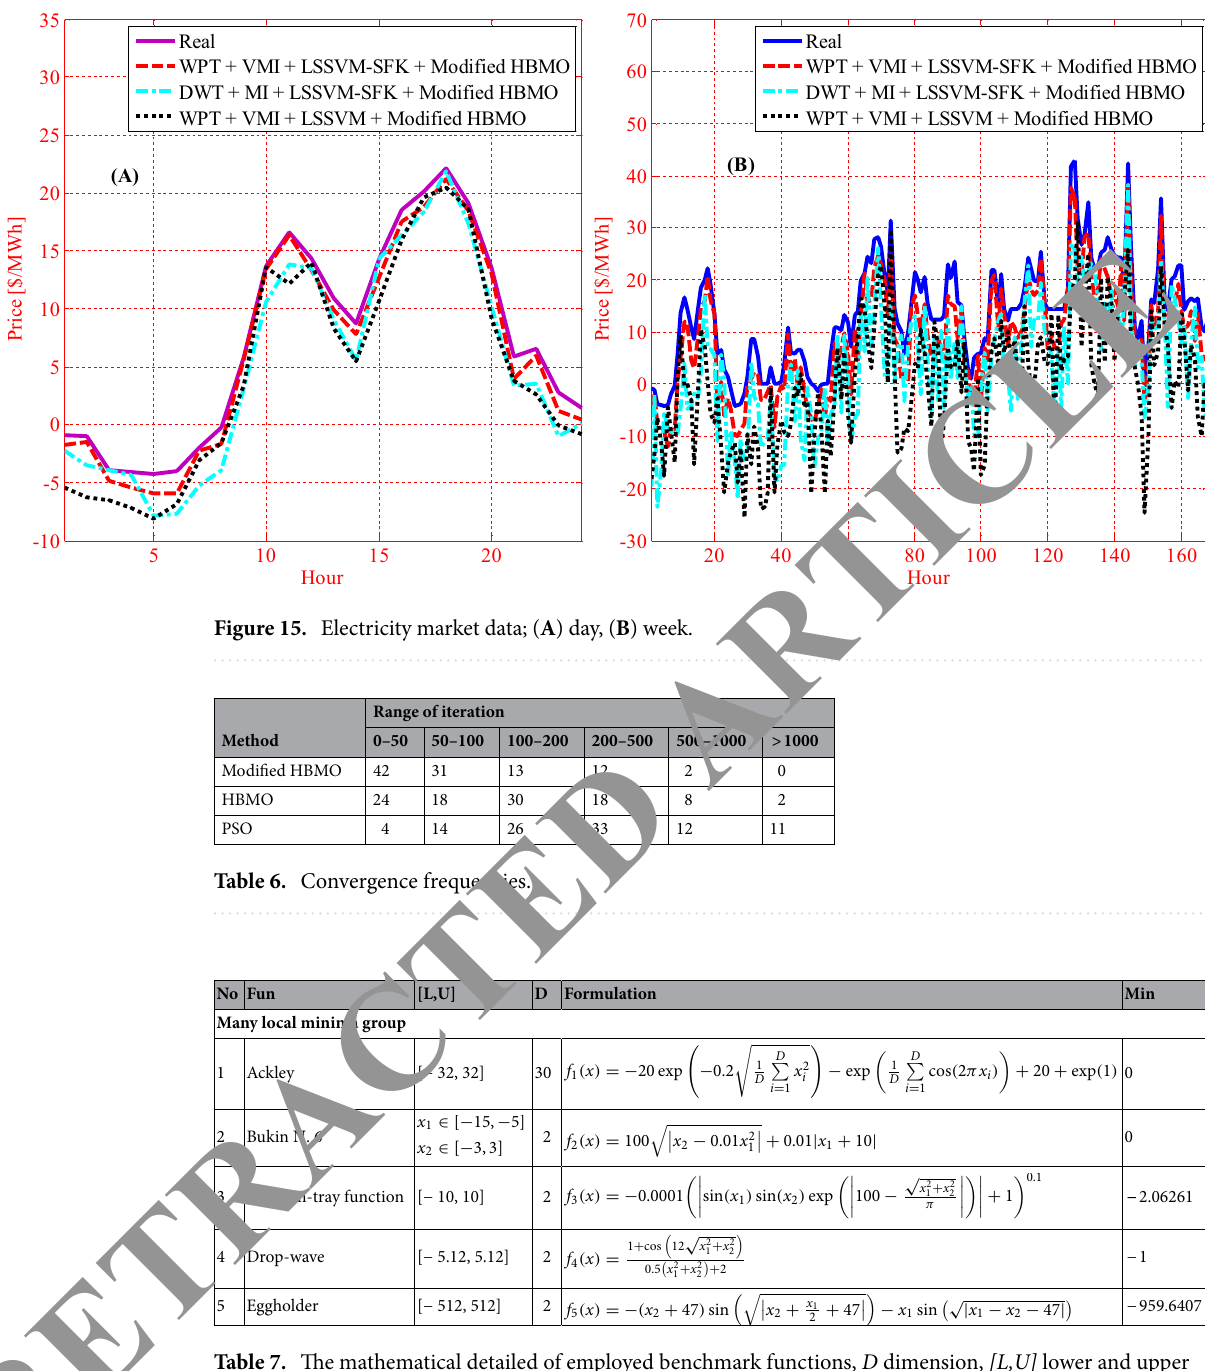
Table 7. The mathematical detailed of employed benchmark functions, D dimension, [L,U] lower and upper bands, Fun function name, No number, Min minimum